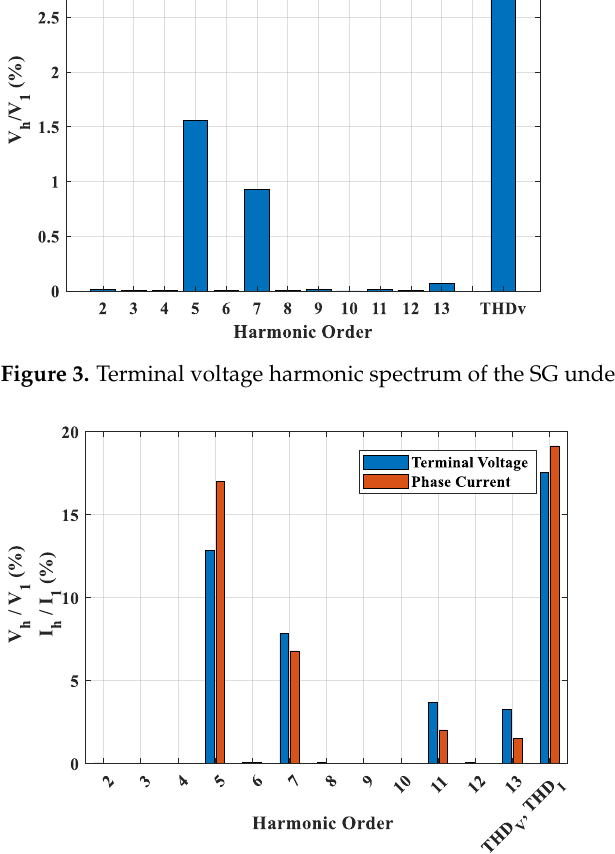
Figure 4. Terminal voltage and phase current harmonic spectrum of the SG under the rated loading condition.